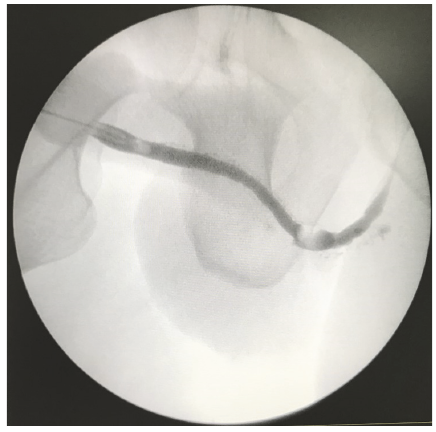
Figure 4: Retrograde urethrography at 10